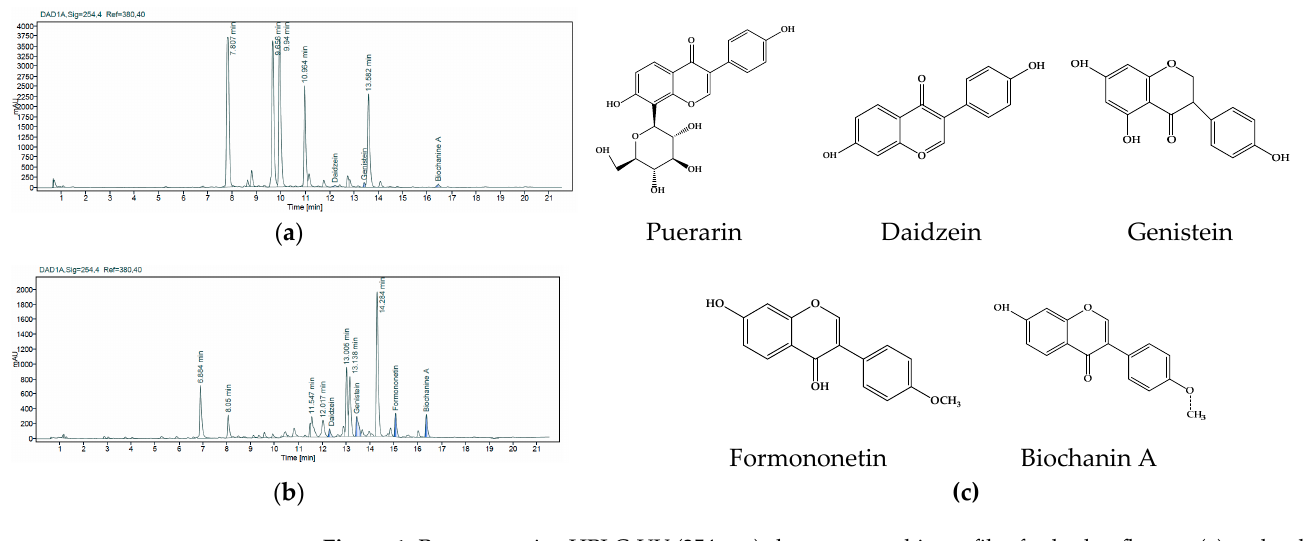
Figure 1. Representative HPLC-UV (254 nm) chromatographic profiles for kudzu flowers ( a ) and red clover ( b ) extracts and chemical structures of isoflavones; puerarin, daidzein, genistein, formononetin, and biochanin A ( c ). Table 1. Results of quantification of the isoflavones of kudzu flowers and red clover flower extracts. Parameters